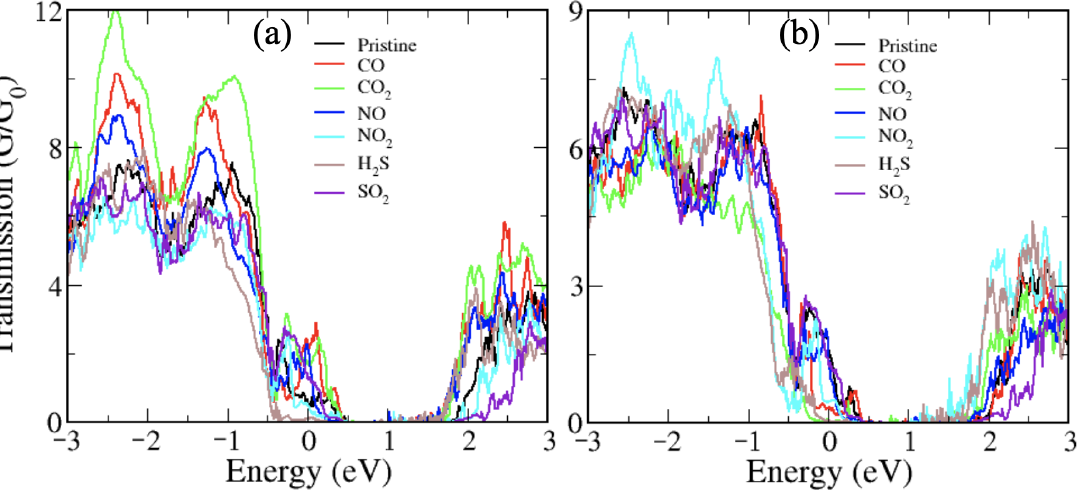
Figure 7. Transmission spectra of the Janus NbSeTe monolayer for ( a ) gas molecules absorbed on the Se-side and ( b ) gas molecules absorbed on the